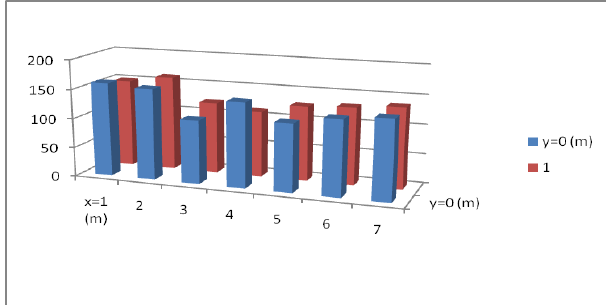
Figure 9: Electrical potential distribution (in mV) on the survey area using copper stake